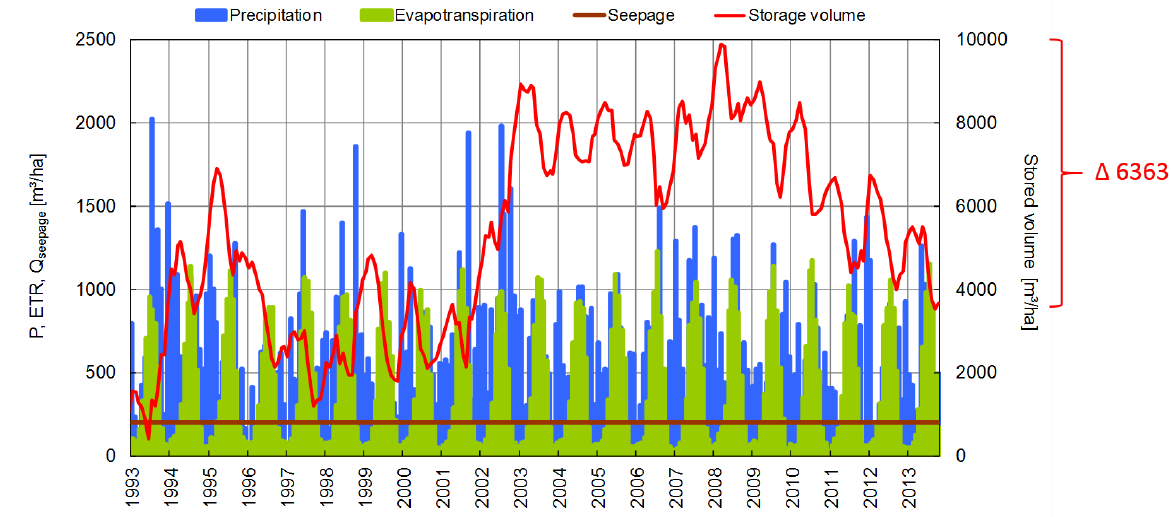
Figure 10. Non-stationary monthly water balance components (precipitation, evapotranspiration, constant seepage) and resulting stored volume for the Sphagnum farming site (in m³ ha -1 ) over the period 1993–2013, calculated using precipitation data (for Bremen) provided by the German Meteorological Service